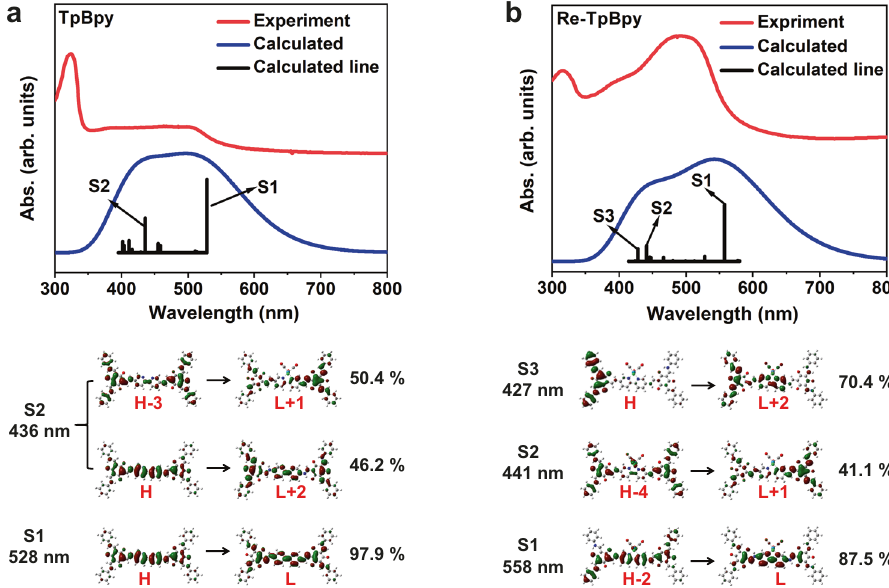
Fig. 3 TD-DFT calculation of the samples. UV − vis absorption spectra of ( a ) TpBpy and ( b ) Re-TpBpy compared with TD-DFT calculated fragment. Source data are provided as a Source data fi